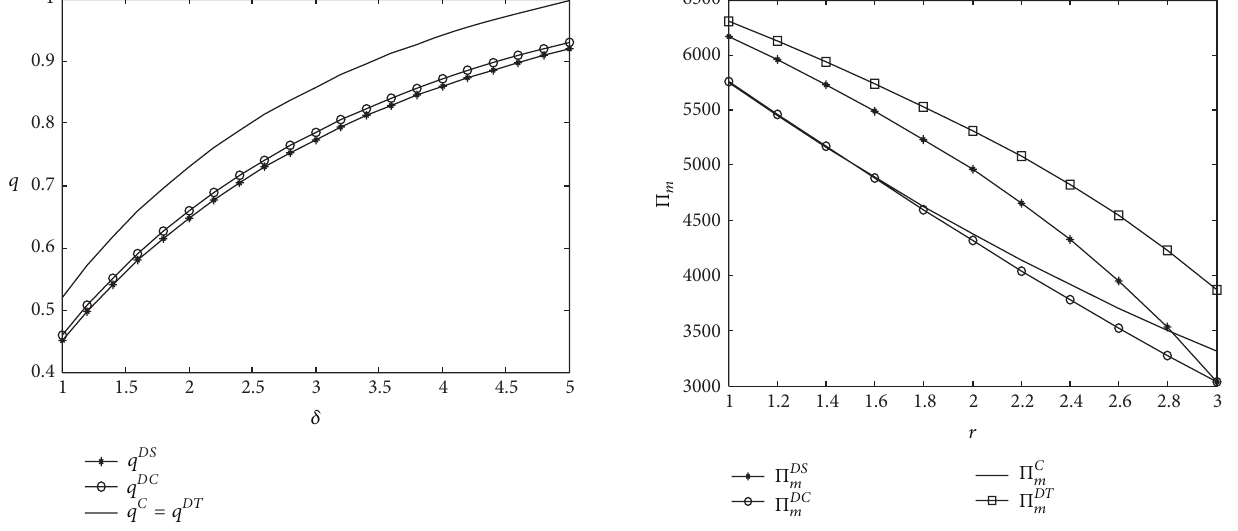
whether in case of decentralized decision or centralized deci- sion. The increment of optimal emission reduction decreases with 𝛿 but that of the optimal promotion level increases with 𝛿 between different decision-making modes.